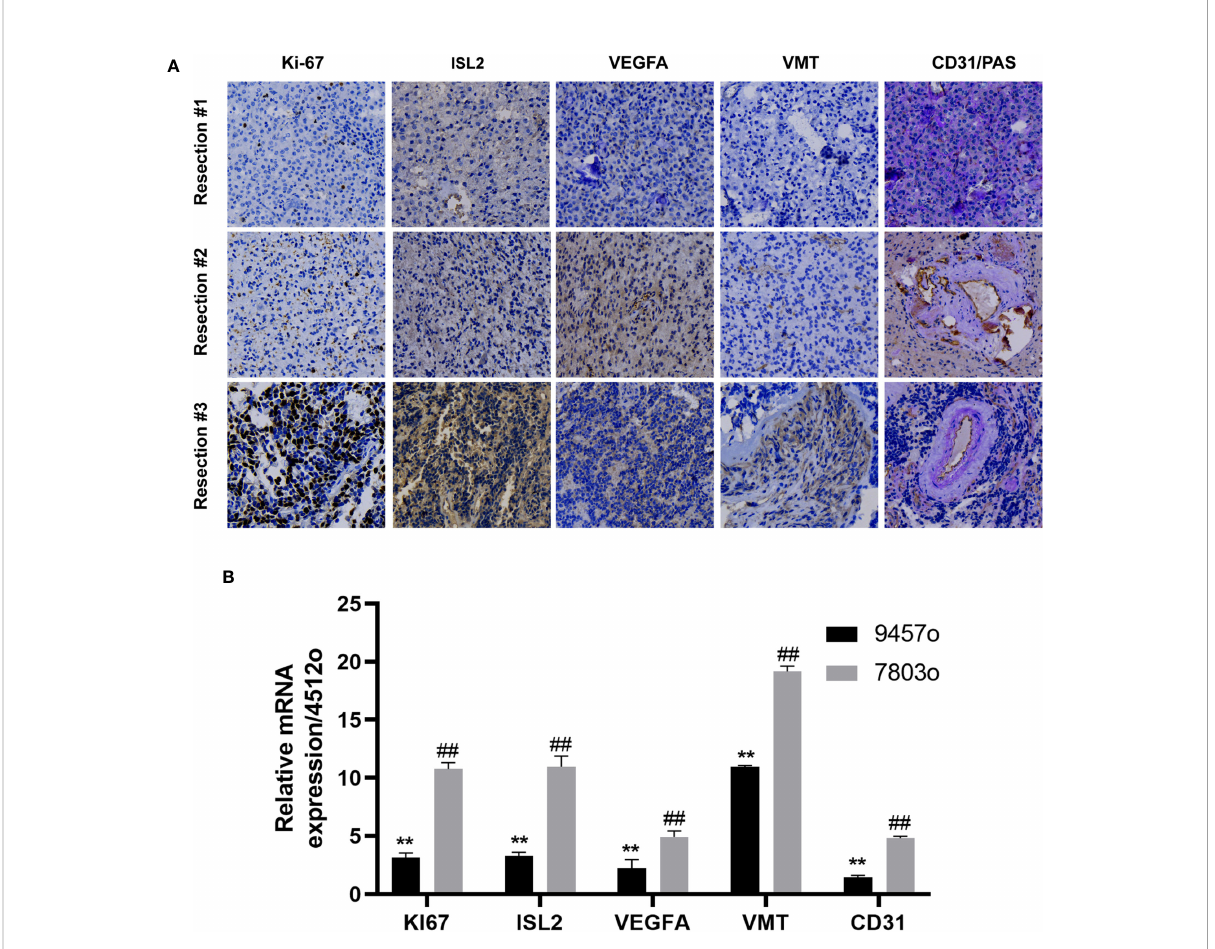
FIGURE 2 ISL2 was highly expressed with recurrence of oligodendroglioma. (A) Histopathological examination. The expression of Ki-67, ISL2, VEGFA, VMT and CD31/PAS in specimens collected from the same patient at three timepoints in the disease course was evaluated by IHC staining (40X). (B) The mRNA expression of Ki-67, ISL2, VEGFA, VMT and CD31 in specimens collected from the same patient at three timepoints in the disease course was determined by RT – PCR. ** p<0.002; ##